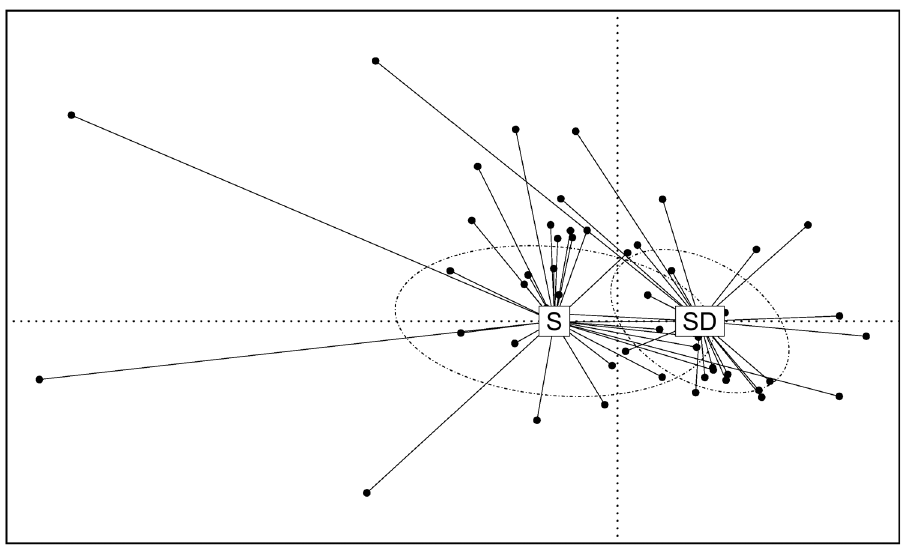
Fig 2. Canonical Correlation analysis based on the log-transformed abundance of 44 OTUs. Patient conditions were used as constraining variable. Two first components (CCA1 and CA1) were plotted accounting for 15.6% of overall inertia of the data set. Individuals (represented by points) were clustered, and centroids were computed for each group. Ellipses were drawn using the standard deviation of points belonging to the same cluster with a confidence limit of